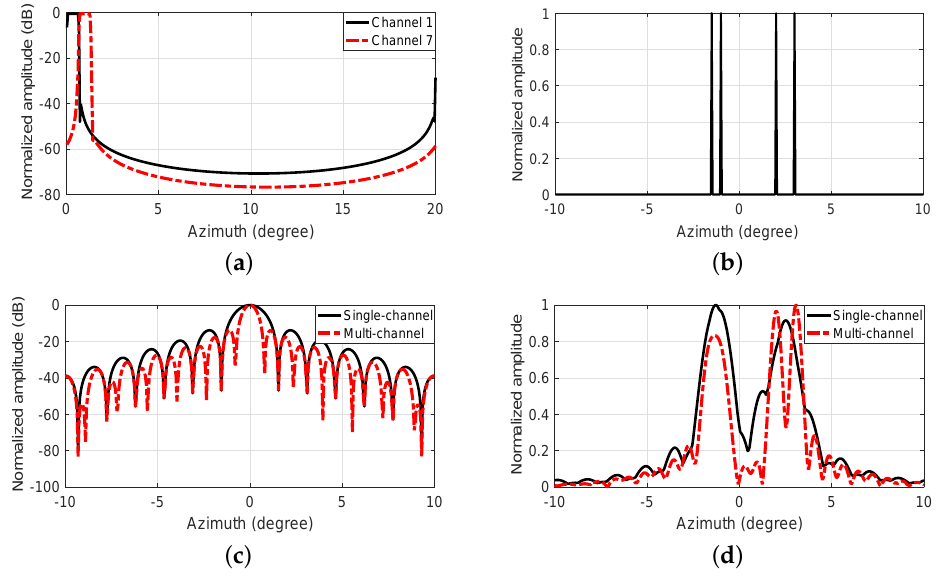
Figure 8. Scattering information and comparison charts of single and multiple channel. ( a ) Angular spectrum of antenna pattern; ( b ) Scattering information; ( c ) Antenna pattern; ( d ) Echo